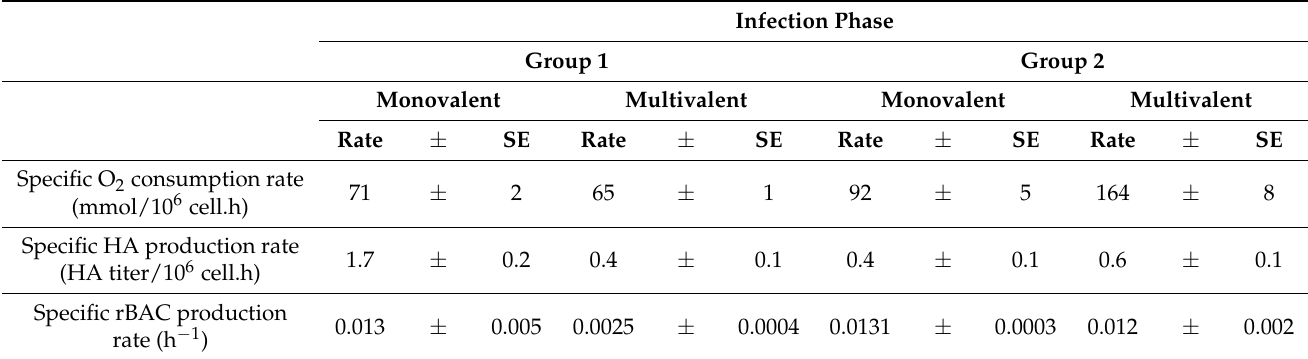
Table 3. Bioprocess-related reaction rates during the production of influenza